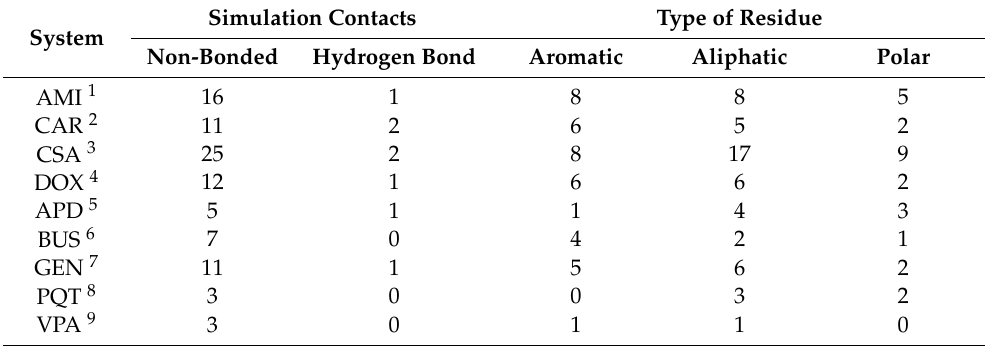
Table 1. Number and type of P-gp residues involved in non-bonded and hydrogen-bond contacts. Simulation Contacts Type of Residue System Non-Bonded Hydrogen Bond Aromatic